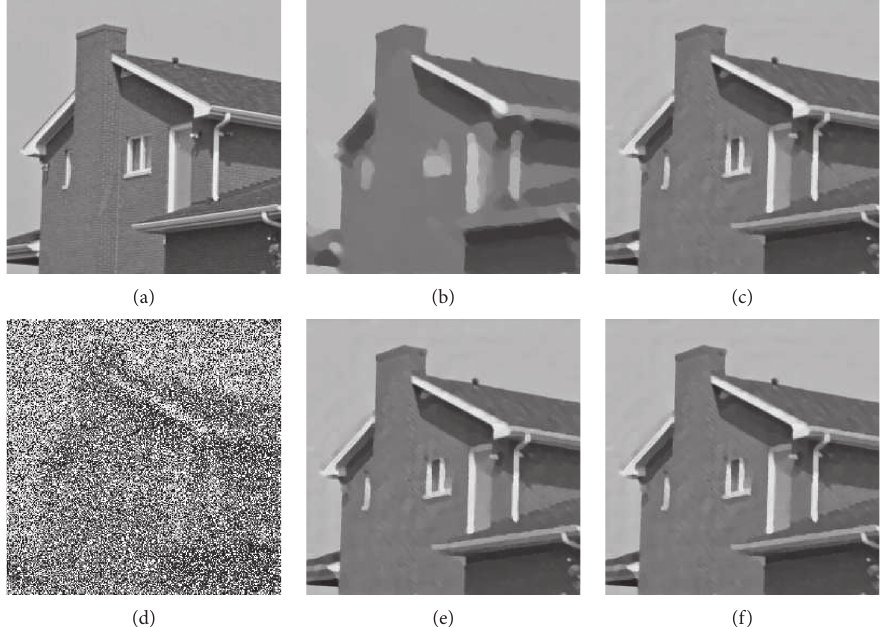
Figure 3: The recovery results (House 256) by Motion blur with 60% SP noise. (a) Original. (b) TVL1, PSNR � 23.739. (c) TVSCAD, PSNR � 29.7605. (d) Motion blur (lev � 0.6). (e) TVLog, PSNR � 29.7593. (f) LogTVSCAD, PSNR �